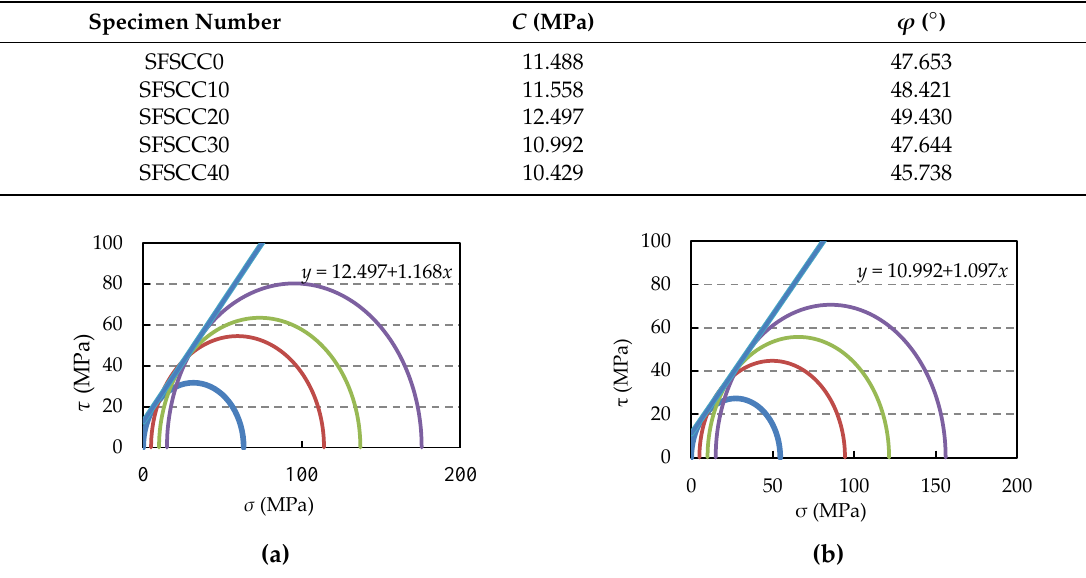
Figure 18. Envelope of SCC partial stress circle: ( a ) SFSCC20; ( b ) SFSCC30. Table 11. Relation of SCC stress circle envelope function.